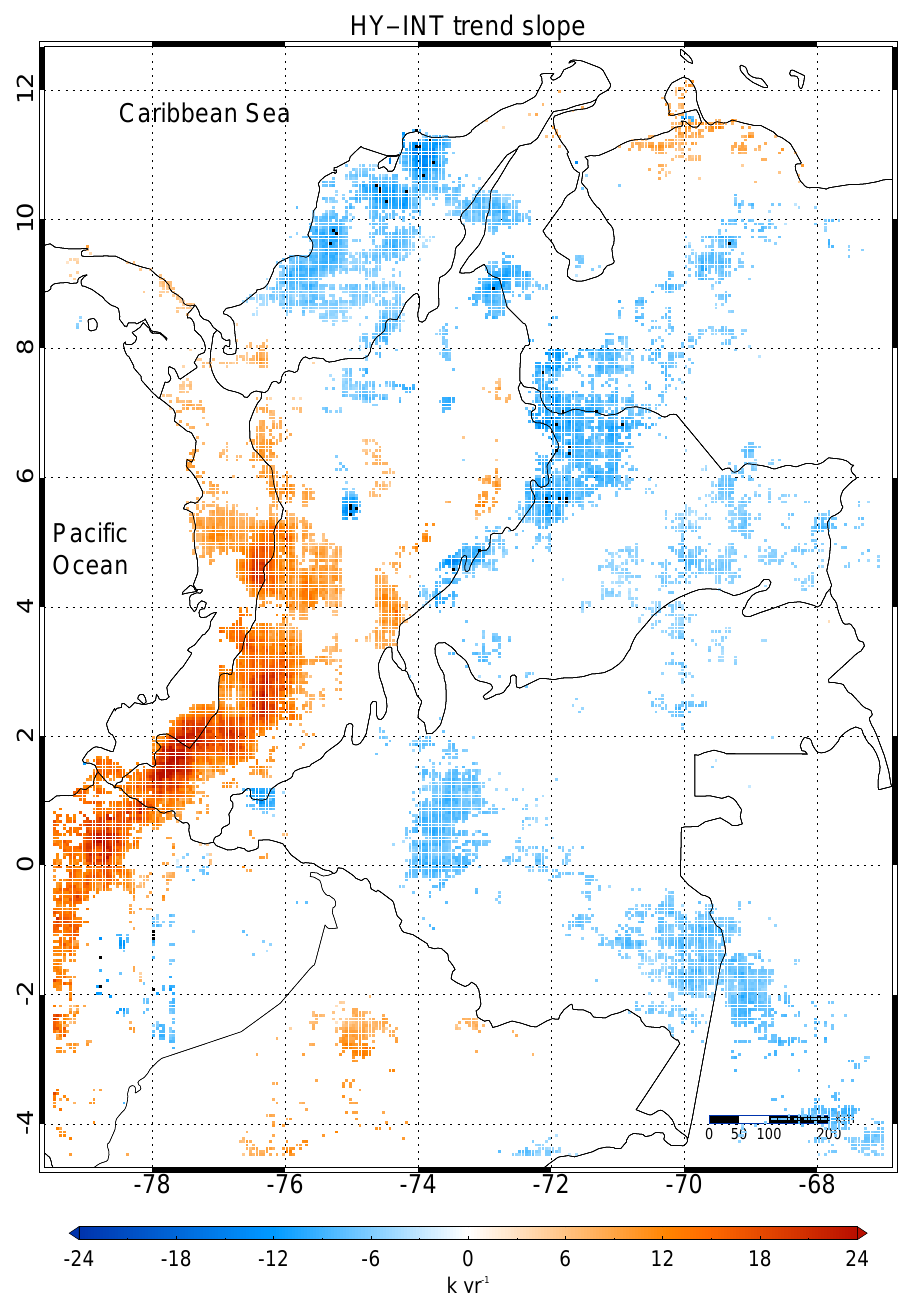
Figure 3. Map of the trend slope for HY-INT for CHIRPS dataset. Non-significant trends are not plotted. Color scale in kyr − 1